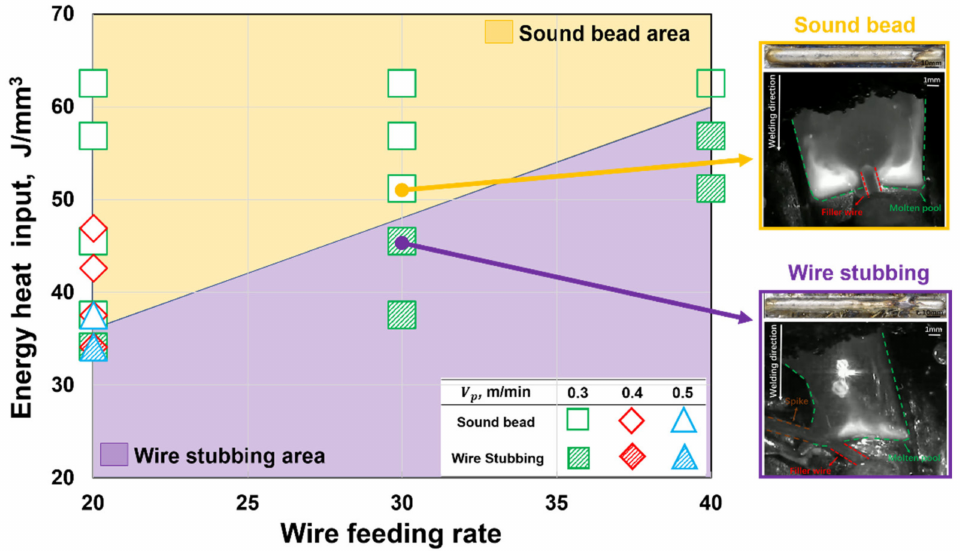
Figure 16. Appearance quality of deposited three layers.